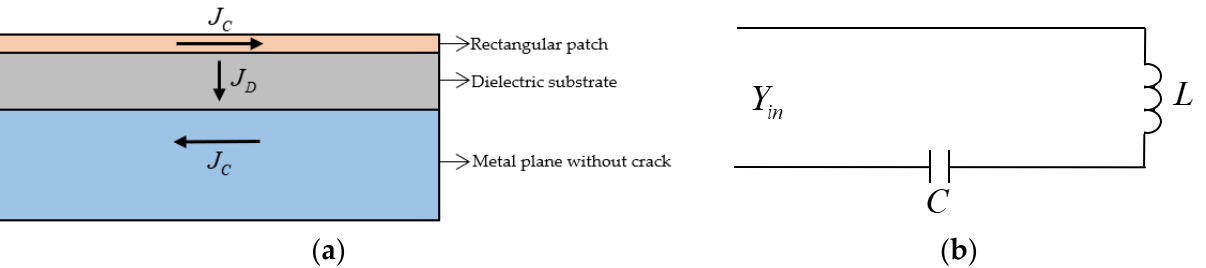
Figure 2. Equivalent model of the sensor without crack on the ground plane. ( a ) Physical model. ( b )Equivalent Circuit.